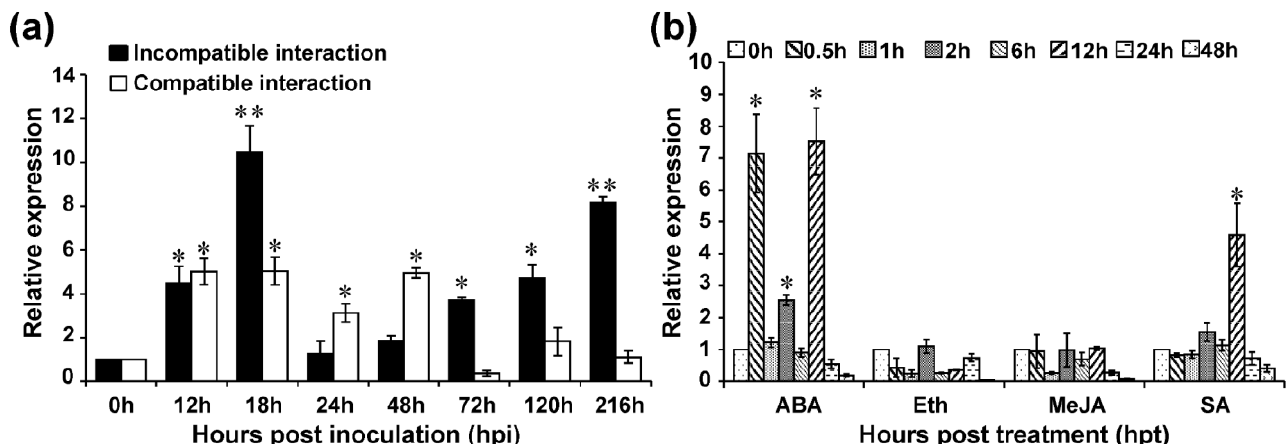
Figure 1. TaMYB391 is induced upon Pst infection and exogenous application of hormones. ( a ) TaMYB391 is induced in wheat leaves upon infection with Pst isolates, CYR23 (incompatible) and CYR31 (compatible) during a 216 h-long time course. ( b ) Exogenous application of hormones in wheat leaves induced the expression of TaMYB391 . Two-week-old wheat seedlings were used in this experiment. Wheat leaves treated with distilled water or 0.1% ethanol were included as a control. TaEF- 1α was used as an internal reference. The relative quantity of expression of TaMYB391 was computed via the comparative threshold (2 −ΔΔCt ) method. The transcript levels were quantified by RT-qPCR and the values were standardized to that of TaEF- 1α and presented as relative changes to the control. The expression level of TaMYB391 at time 0 h was normalized as 1. Error bars represent the variation among three independent replicates. Statistical variations were analyzed using Student’s t -test. *, p < 0.05, **, p <